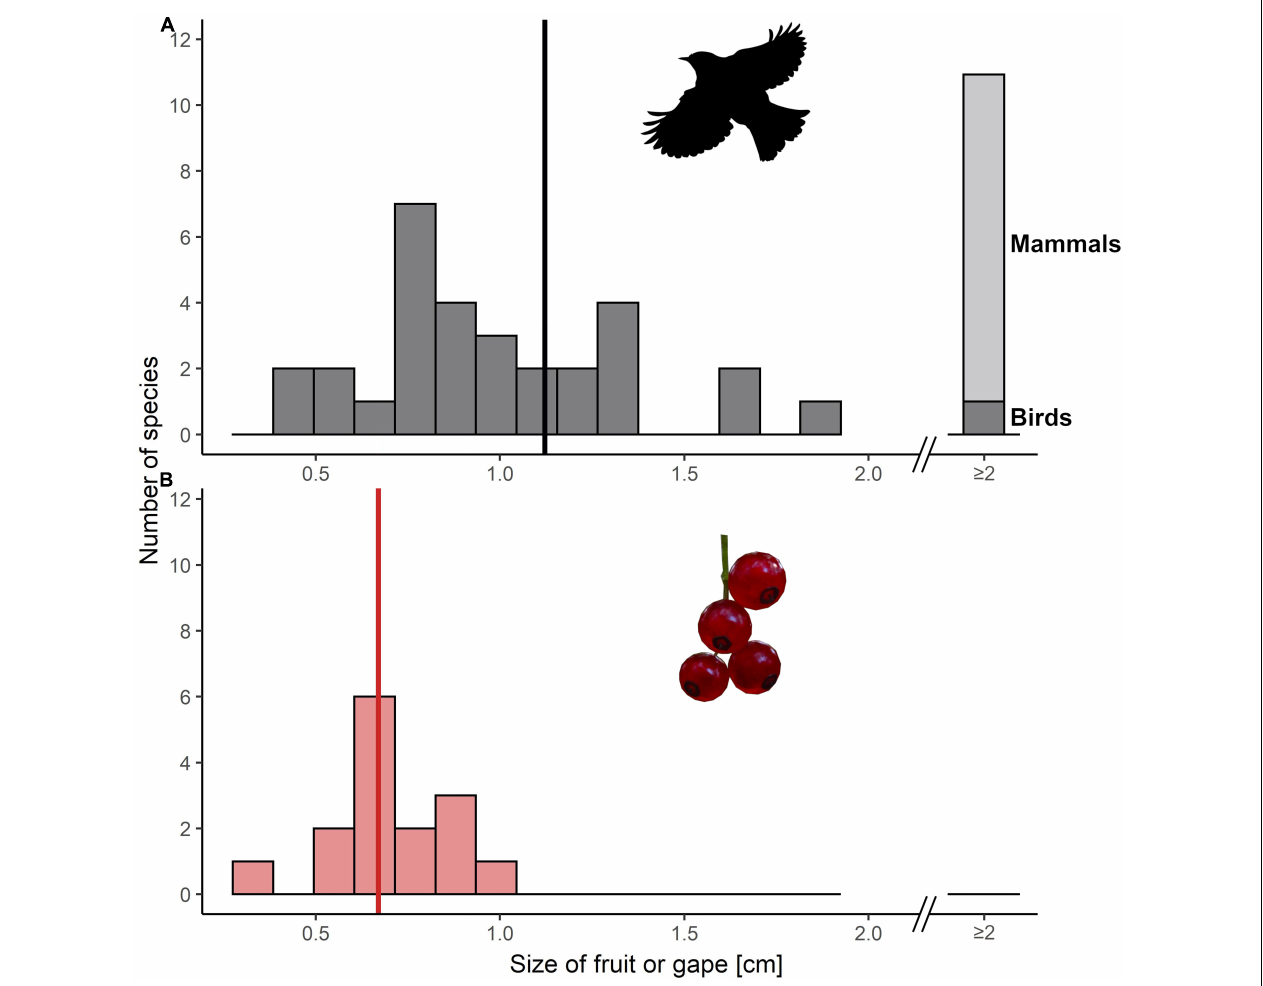
FIGURE 1 | Distribution of (A) the gape widths of animal dispersers and (B) the fruit diameter of associated plants at species level in temperate forests in Białowie˙za Forest, Poland. This is a summary of the local plant-frugivore community, whose contributing species were identified either based on fruit removal observations (Albrecht et al., 2013) or based on seeds in scats of animals (Schlautmann et al., 2021). Vertical lines illustrate the median value of a